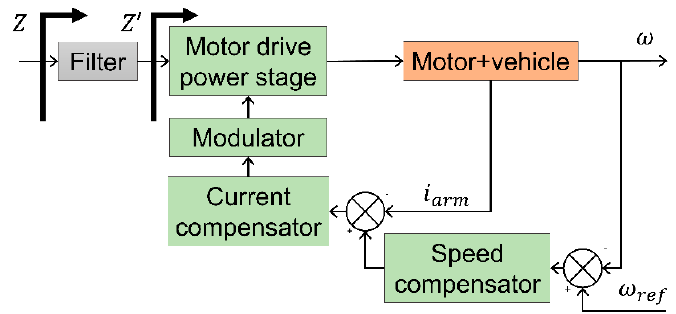
Figure 2. Block diagram of the motor drive along with the motor and vehicle.